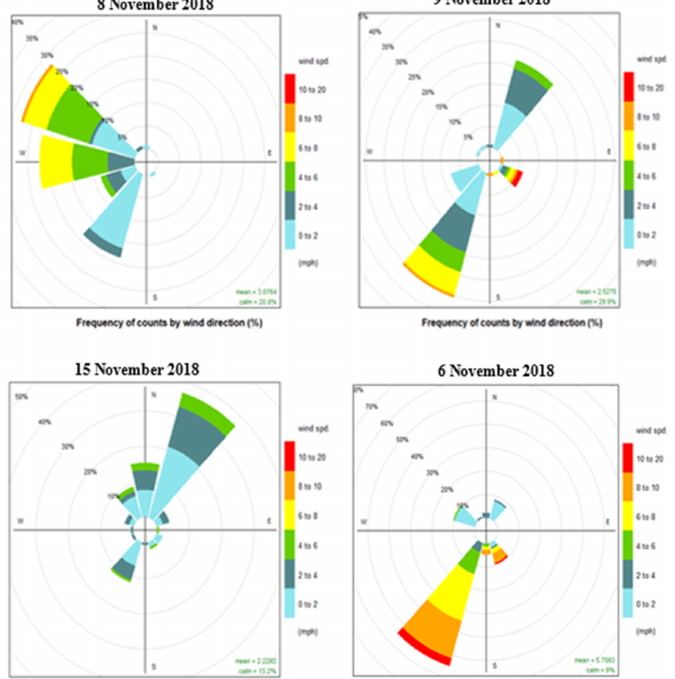
Figure 3. Wind rose plots for maximum and minimum concentrations of daily air pollutants at the Port of Albany. The average daily size ‐ segregated particle number concentrations are given in Table 2. Large variations in number concentration were observed for particles in the smallest 11 of the 17 size bins, i.e., from 0.3 μ m to 2.685 μ m. The smallest particle sizes between 0.3 μ m and 0.579 μ m exhibited the greatest variability. Table 2. Daily average statistics of particle number concentration (#/cm 3 ) for size ‐ segregated PM (0.3 ‐ 10 μ m) during the study period at the Port of Albany, New York. Size ‐ Segregated PM